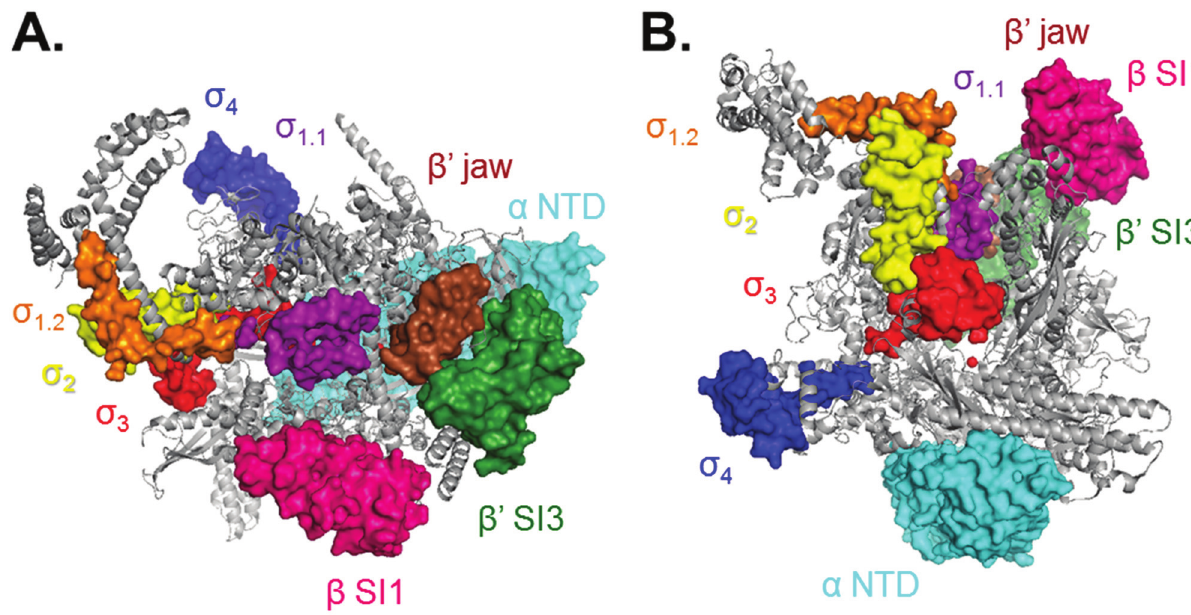
Figure 2. Structural representation of key functional regions of E(cid:3) 70 holoenzyme. Structure created from PDB 4LK1, looking down the cleft in ( A ) and rotated 90° into the page and 90° counterclockwise in ( B ). Colors of regions of (cid:3) are the same as in Figure 1. Additionally shown: (cid:5)' jaw ((cid:5)' 1149–1990), brown; (cid:5)' SI3 ((cid:5)' insert 6; (cid:5)' 943–1130), green; (cid:5) SI1 ((cid:5) insert 4; (cid:5) 225–343), pink; active site Mg 2+ , red ball; (cid:4)NTD ((cid:4) 1–234),